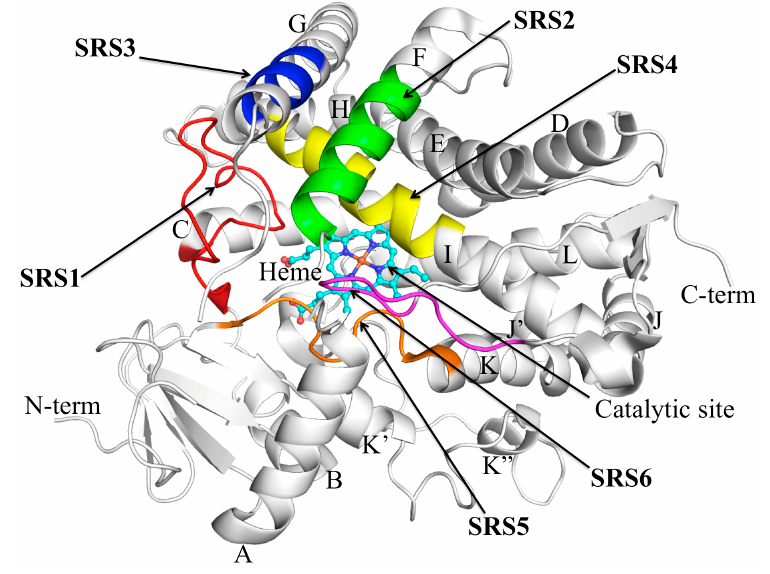
Figure 1. CYP2C9 structure showing substrate recognition sites (SRS) according to Gotoh [28]. The SRS are denoted by arrows: SRS1 (red), SRS2 (green), SRS3 (blue), SRS4 (yellow), SRS5 (orange) and SRS6 (magenta). The secondary structure elements of the rest of the protein are shown in white. The haem molecule is shown in ball and sticks with C, O, N, and Fe atoms in cyan, red, blue, and orange, respectively (from [29]). Reproduced with permission from Nair, P.C.; McKinnon, R.A.; Miners, J.O. Cytochrome P450 structure–function: insights from molecular dynamics simulations. Drug Metab. Rev. 2016 , 48 , 434–452; published by Taylor and Francis,